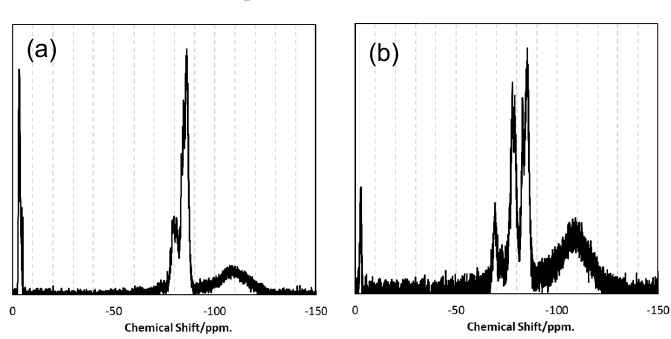
Figure 4. 29 Si NMR spectra for ( a ) VH-SQ and ( b ) St-H-SQ.